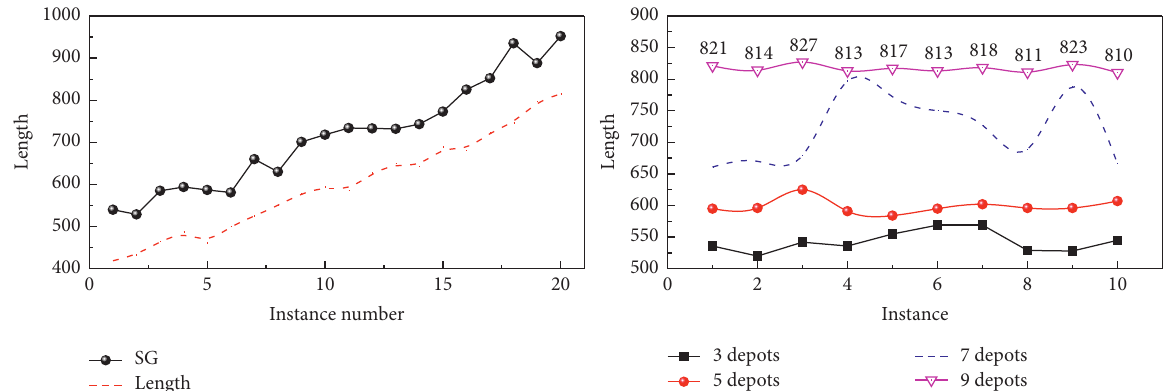
Figure 8: Effect of the values of the genetic algorithm parameters on the computational results in the approximation scheme.